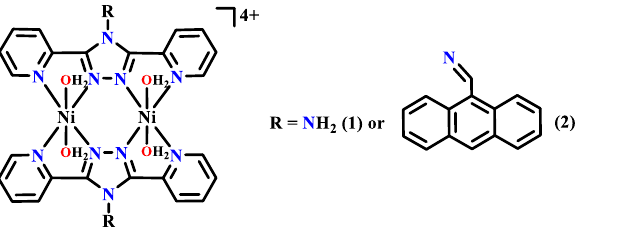
Figure 37. Symmetric binuclear nickel(II) complexes of 9-anthrahydrazone with triazole derivative as a side chain.